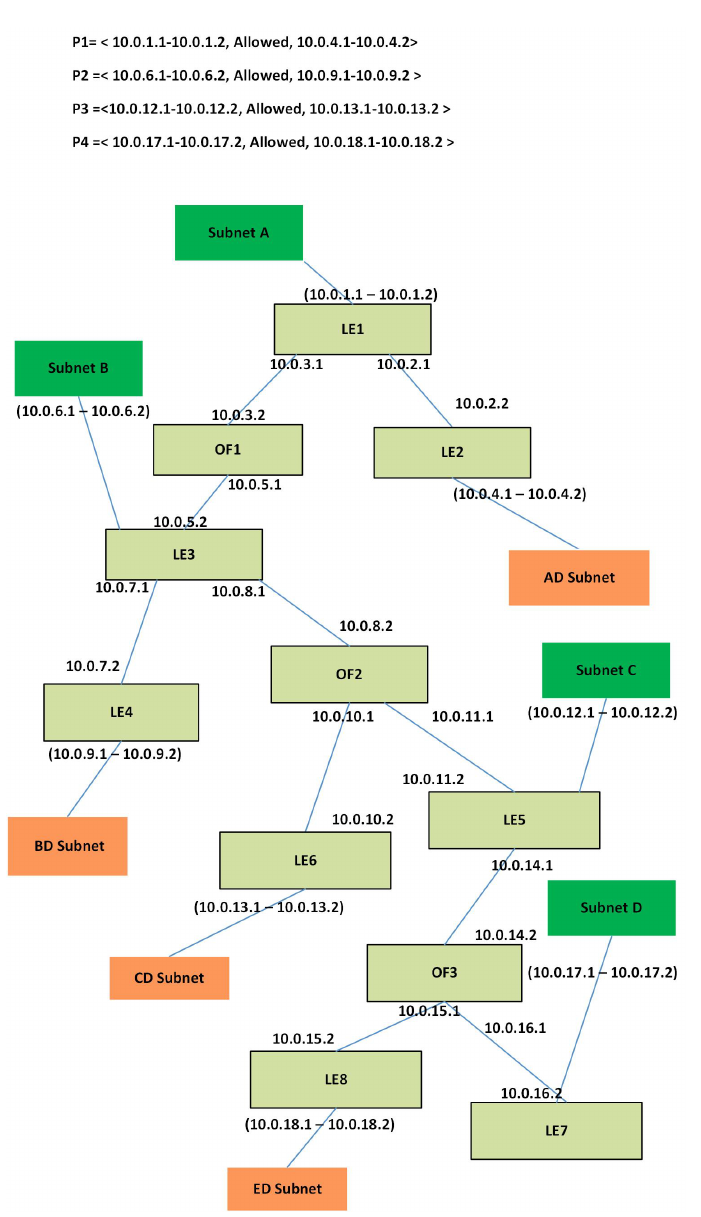
Figure 11. Decision Tree for Multiple